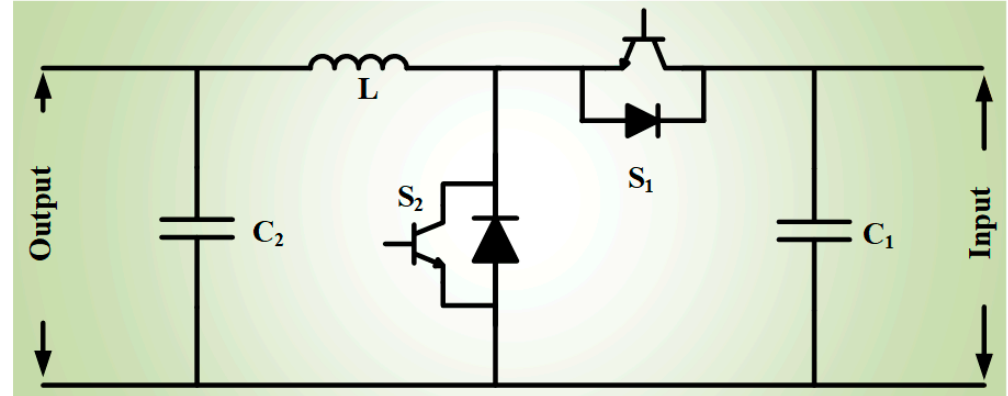
Figure 2. Bi-directional chopper-based battery charger.